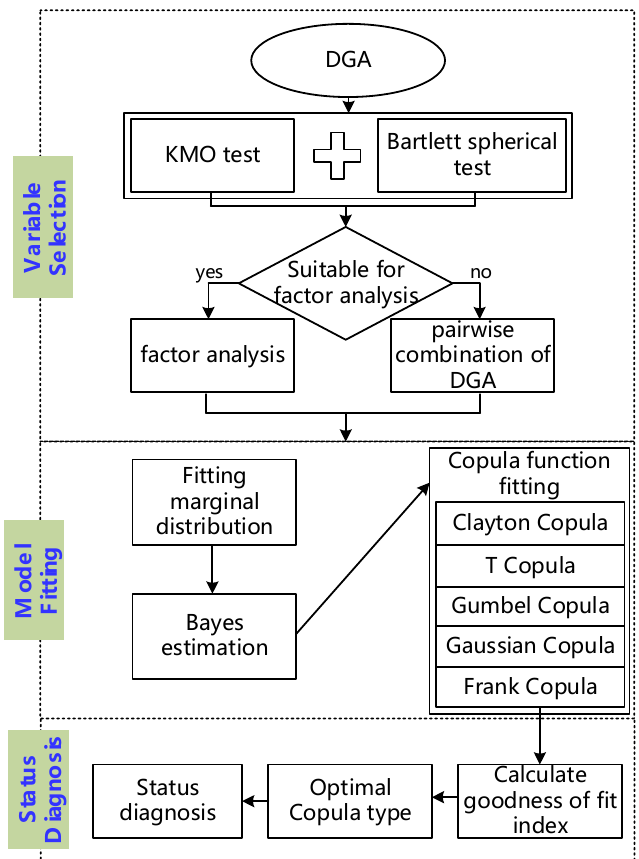
Figure 1. The process flow chart of dissolved gases in oil based on a copula function.